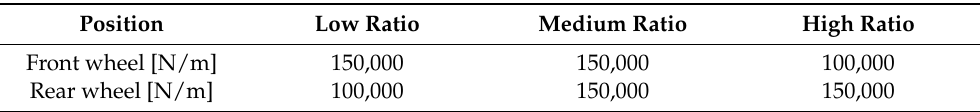
Table 6. The values of stiffness coefficient grouping. Position Low